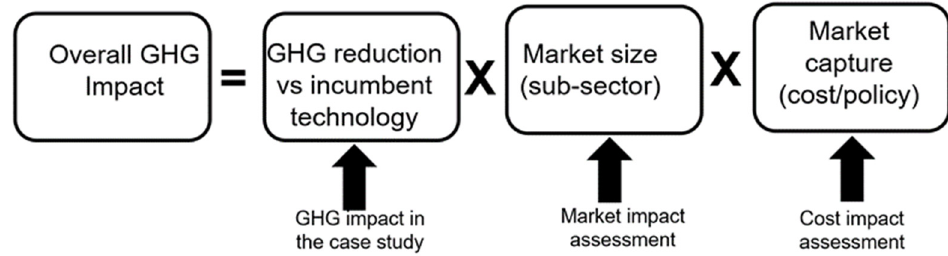
Figure 9. Methodology overview for best available technologies (BAT), including screening and